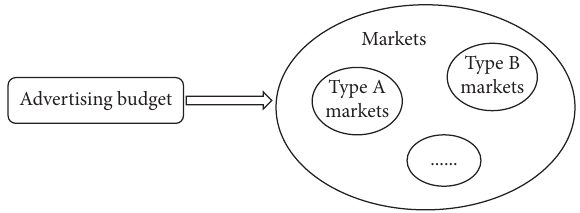
Figure 1: Two special types of markets in advertising budget